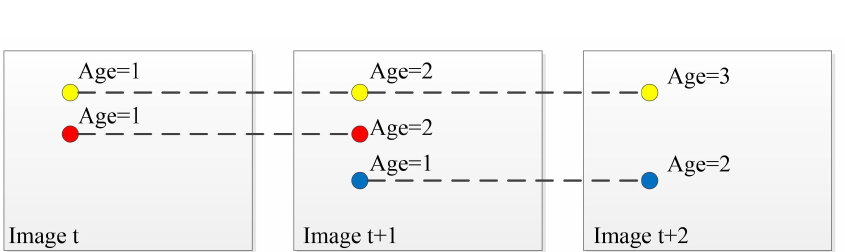
Figure 5. The feature’s age is increased by one if it is tracked in the current frame. The yellow point should be chosen first in Image t +